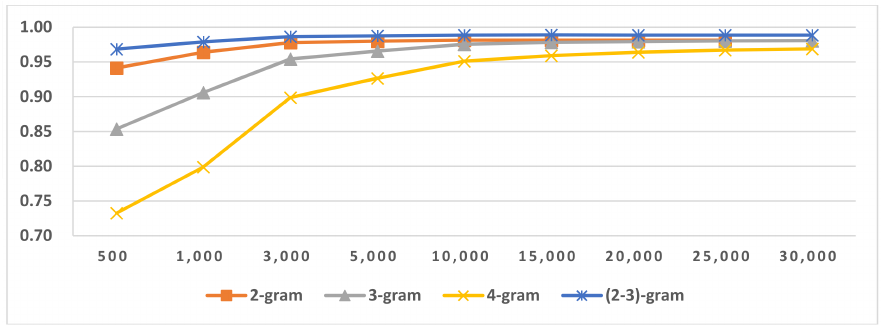
Figure 17. LI in Indo-European/Italic in Latin script